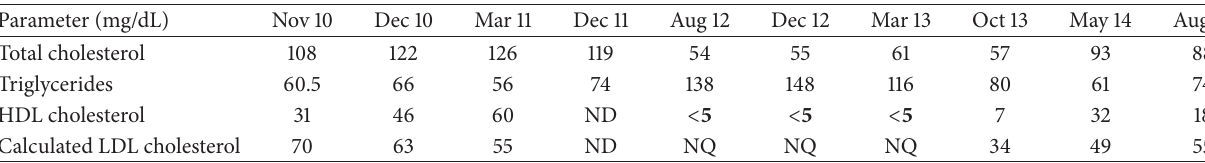
Table 1: Serial lipid measurements in the patient.